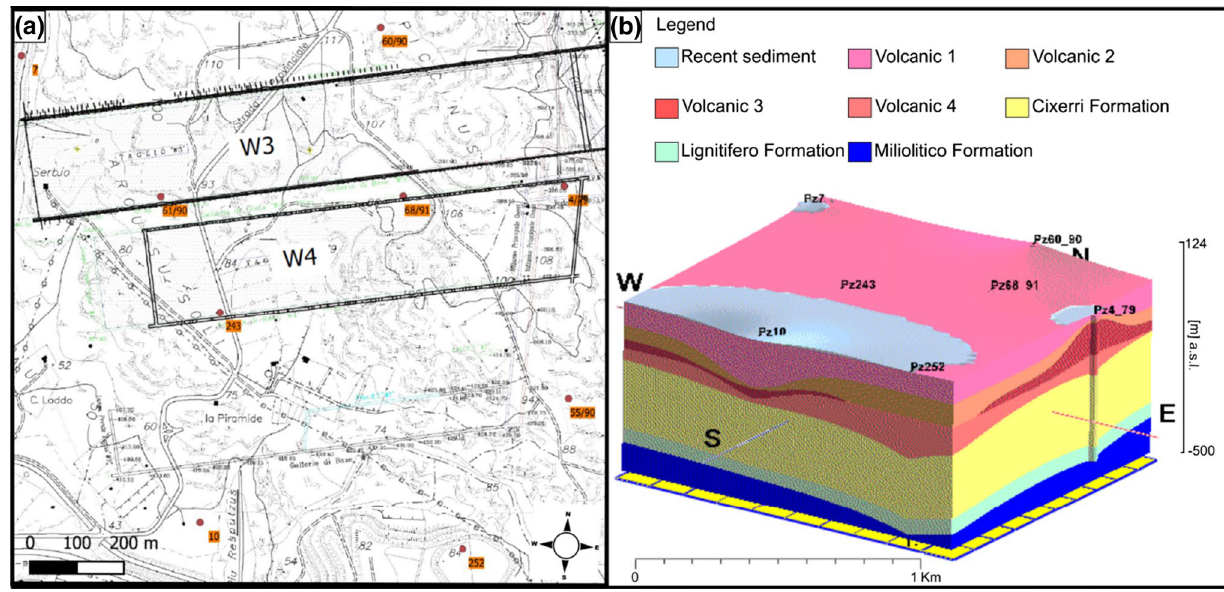
Fig. 5 a Location of stratigraphic logs used to elaborate b 3D geological model of subsurface